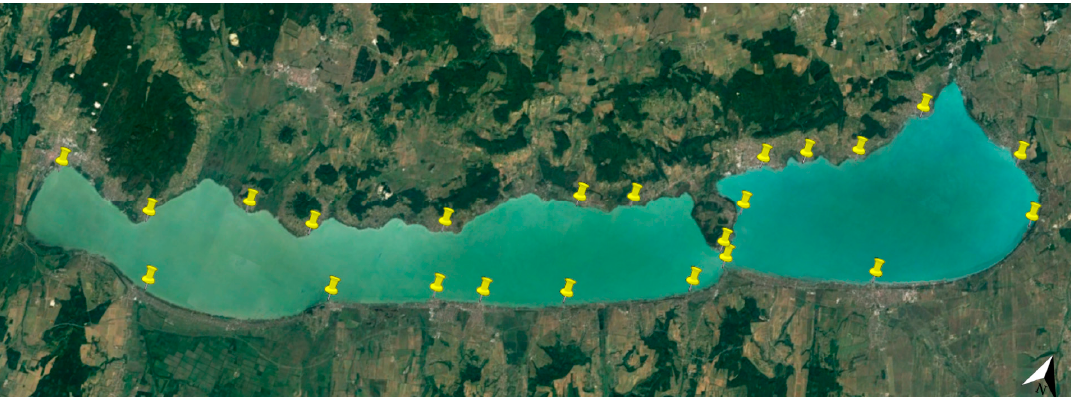
Figure 4. The number of anglers’ ports per town/village at Lake Balaton based on [55]. 2.2. The Direction of the Development of the Sailing Marinas at Lake Balaton and Its Connections to Energy Storage Developments Figure 2 illustrates well that sailing marinas have a great significance in the shipping activities of Lake Balaton. A part of this study was also the determination of the number of permanent berths and visitors’ berths at the sailing marinas of the towns/villages of Lake Balaton, since in possession of this data, the numbers of small electric boats at pre- sent and in the future could also be established. The initial data and information for this were provided by the Government Agency of the City of Budapest [57] and the atlas of the ports and marinas of Lake Balaton [58]. Moreover, how large the present and the pre- dicted energy storage capacities of the small electric boats moored in the sailing marinas are has also become a timely question by now. The input information necessary for an- swering this was supplied by the Government Agency of the City of Budapest [57], AQWIA Ltd. [59] and Stickl Yachts Ltd. [60]. Stickl Yachts Ltd. [60] and AQWIA Ltd. [59] together have a share of 60% of the market of the registered electric boats in Hungary. This study considered the number of berths in the marinas to remain constant in the fu- ture, since the construction of further facilities around the lake is unlikely [61] because of environmental reasons, among others [62]. The economic environment that supports the spread of small electric boats is extremely important, since it will contribute not only to the development of the green infrastructure at the lake, but also to the process of these vehicles becoming an organic part of virtual generation integration, local energy commu- nities and micro-grid solutions, in accordance with Hungary’s energy strategy for 2030, as these boats can provide a possibility for creating new flexibility services.